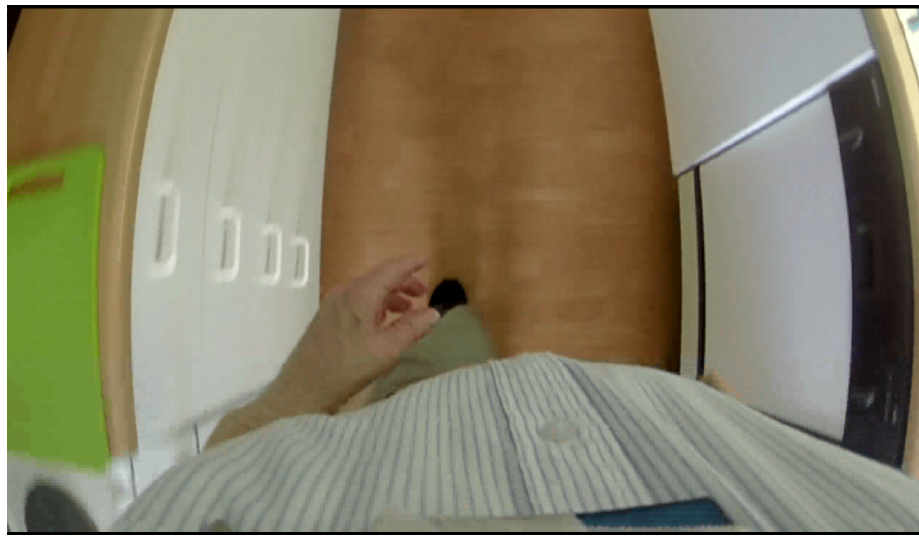
Figure 4. Image of the video recorded by the chest mounted Go-Pro camera. Users placed a paper-bag over the camera during bathroom breaks, which successfully obstructed the view.